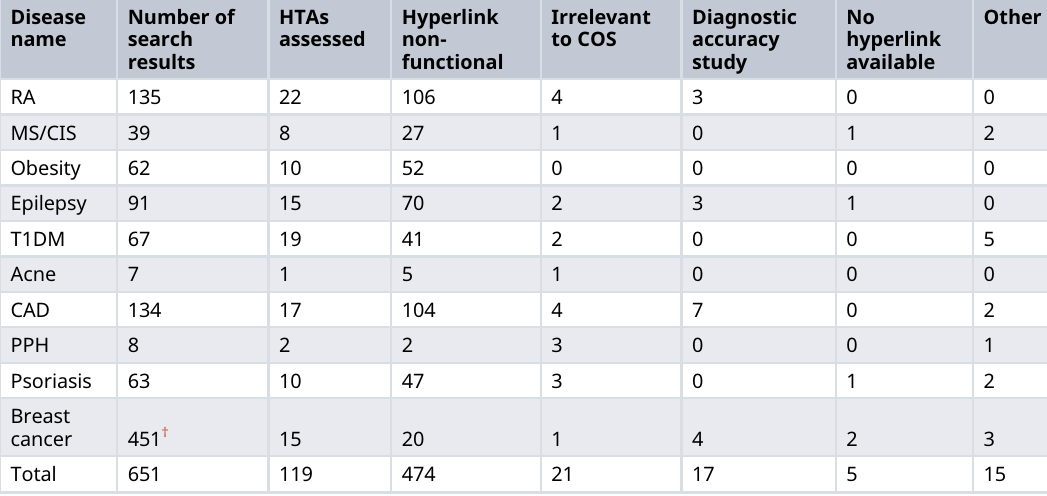
Table 2. Breakdown of database search results for each individual COS. Disease